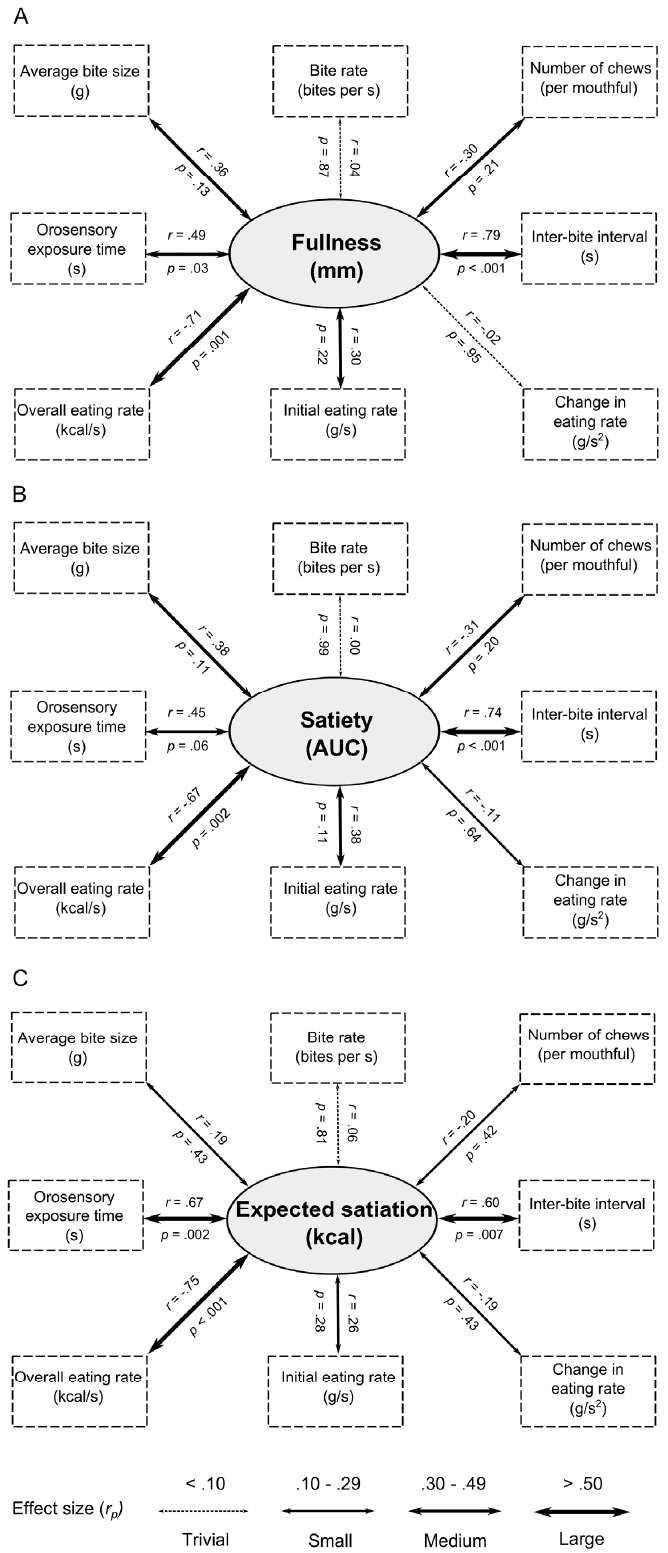
Figure 1. Partial correlations ( r p , controlling for baseline composite fullness) between oral processing behaviours and fullness after consuming the fixed portion (satiation—panel ( A )); fullness for three hours after eating (satiety—panel ( B )); and expected satiation (panel ( C )) Effect sizes are denoted by the width of each arrow.